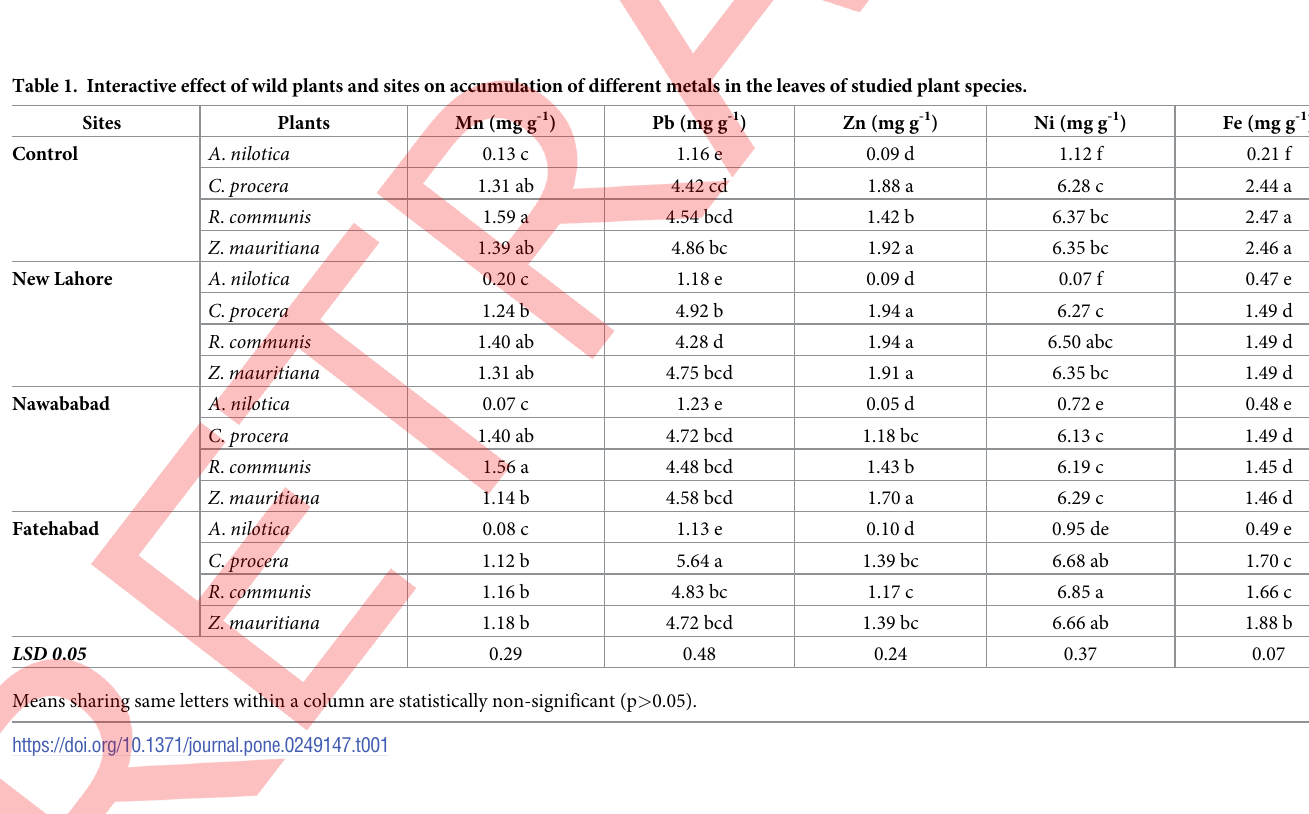
Table 1. Interactive effect of wild plants and sites on accumulation of different metals in the leaves of studied plant species. Sites Plants Mn (mg g -1 ) Pb (mg g -1 ) Zn (mg g -1 ) Ni (mg g -1 ) Fe (mg g -1 )